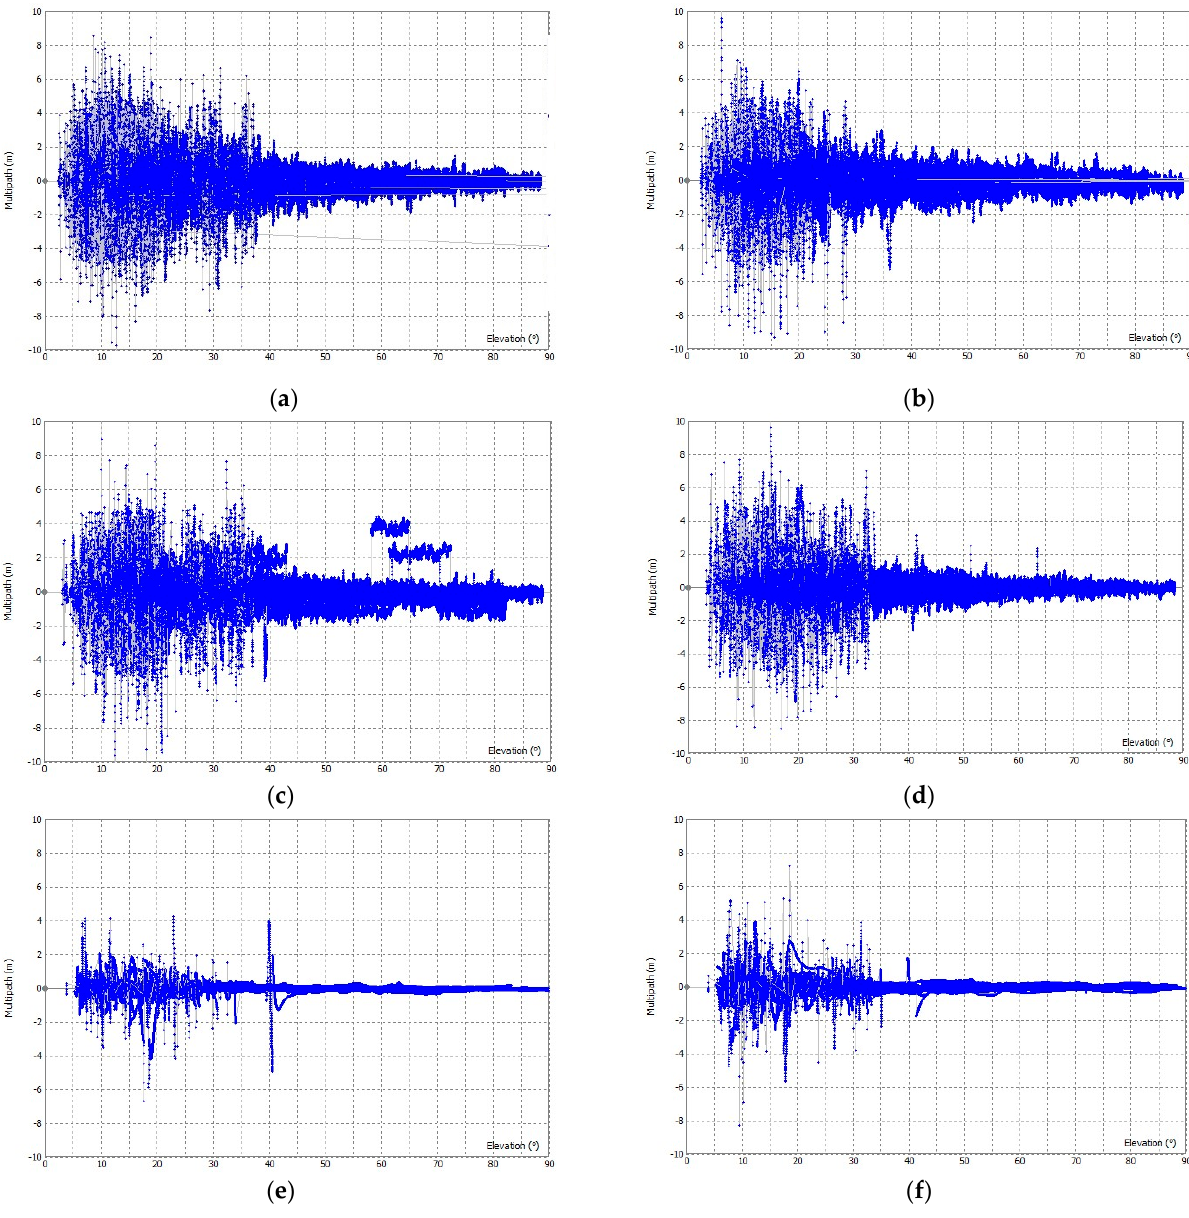
Figure 8. Multipath for code observations in F1 and F2 frequency in urban areas: ( a ) F1 multipath for LC − 1, ( b ) F2 multipath for LC − 1, ( c ) F1 multipath for LC − 2, ( d ) F2 multipath for LC − 2, ( e ) F1 multipath for GD − 1, and ( f) F2 multipath for GD − 1. multipath for GD − 1, and ( f ) F2 multipath for GD −